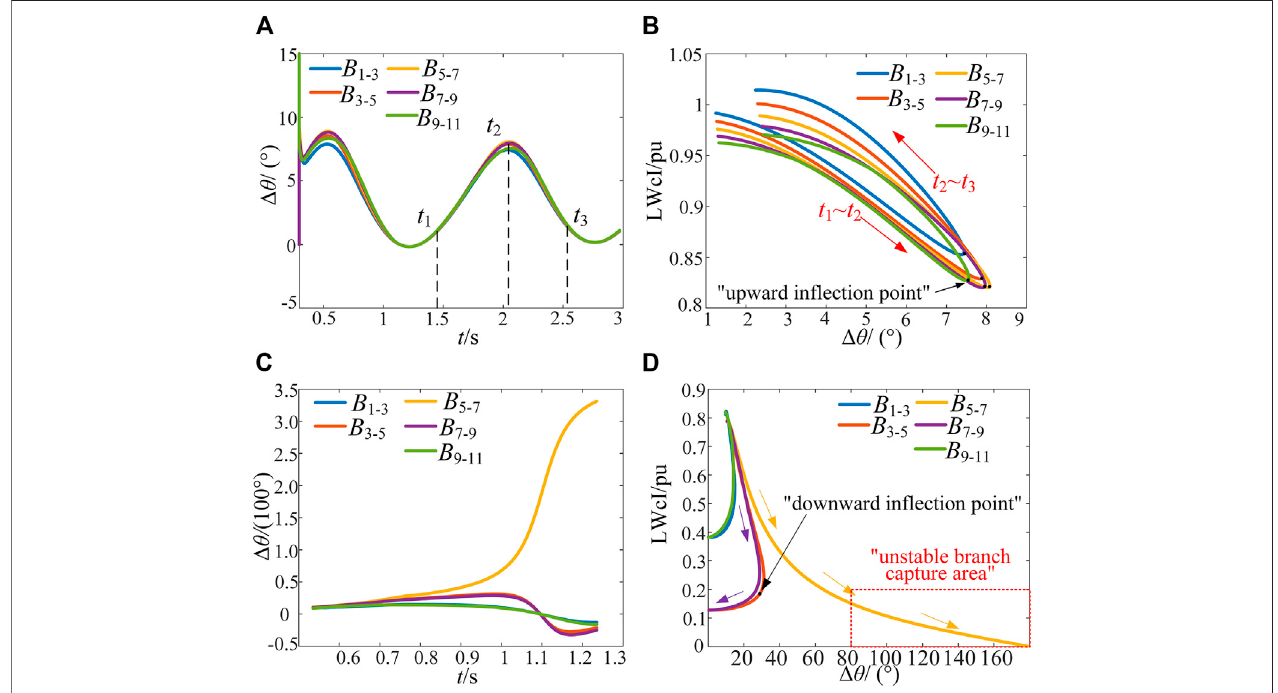
FIGURE 2 | Analysisofbranch trajectory characteristics (A) isthe Δ θ - t curveofdifferentbranches when thesystem isstable (B) istheLWcI- Δ θ curveofdifferentbranches when the system is stable (C) is the Δ θ - t curve of different branches when the system is unstable (D) is the LWcI- Δ θ curve of different branches when the system is unstable.